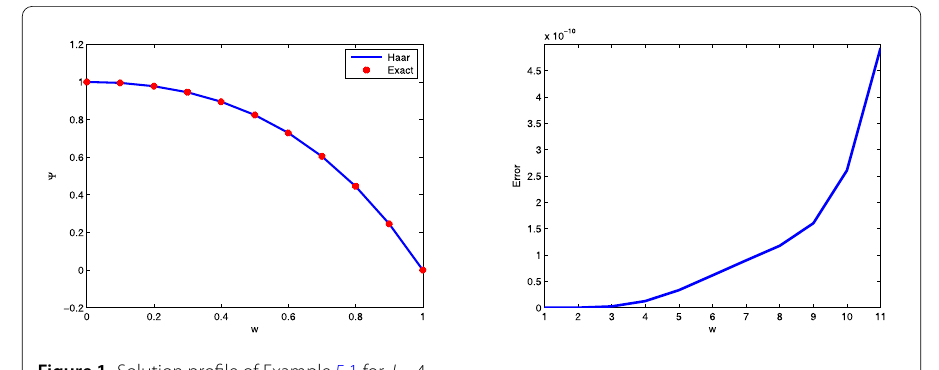
Figure 1 Solution profile of Example 5.1 for J =